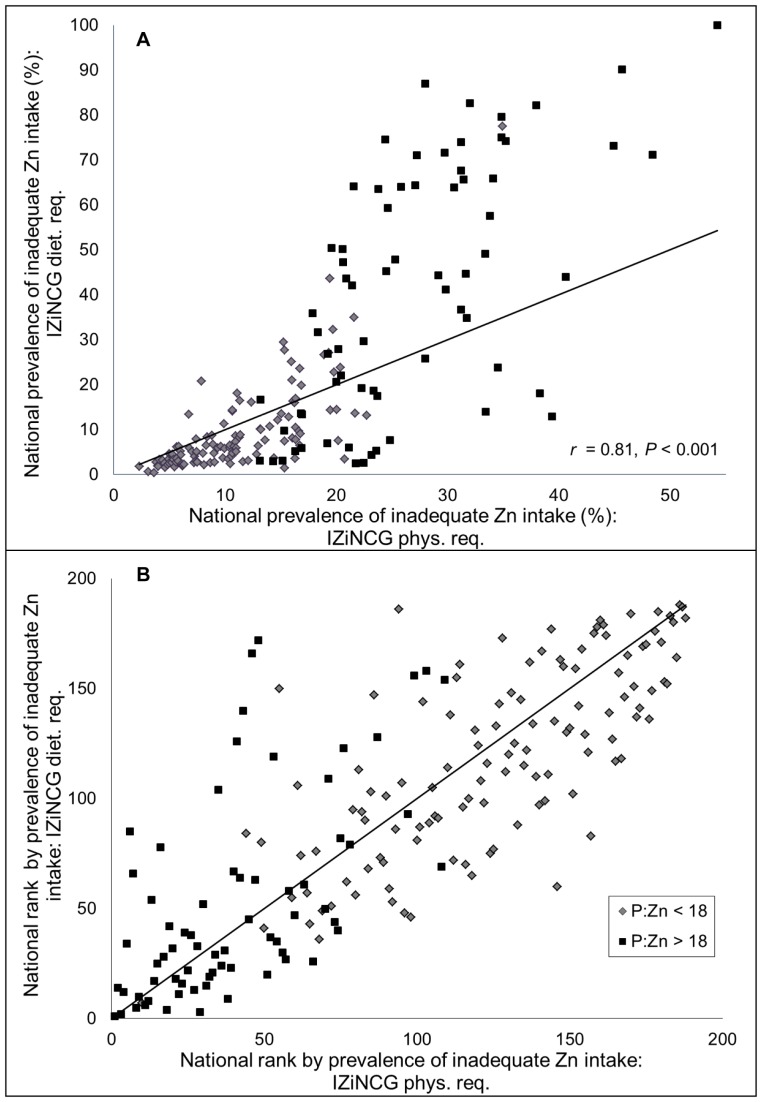
Associations between the (A) national prevalence and (B) country-specific rank order by prevalence of inadequate zinc intake as estimated by different IZiNCG Zn requirements.Estimates are based on physiological and dietary zinc requirements developed by the International Zinc Nutrition Consultative Group. The composite nutrient database and a 25% inter-individual CV in intake are used for all estimates. The solid line represents the line of identity (intercept = 0, slope = 1). N = 188 countries. Country rank orders were assigned in descending order, with the country with the highest estimated prevalence of inadequate zinc intake having the lowest rank.